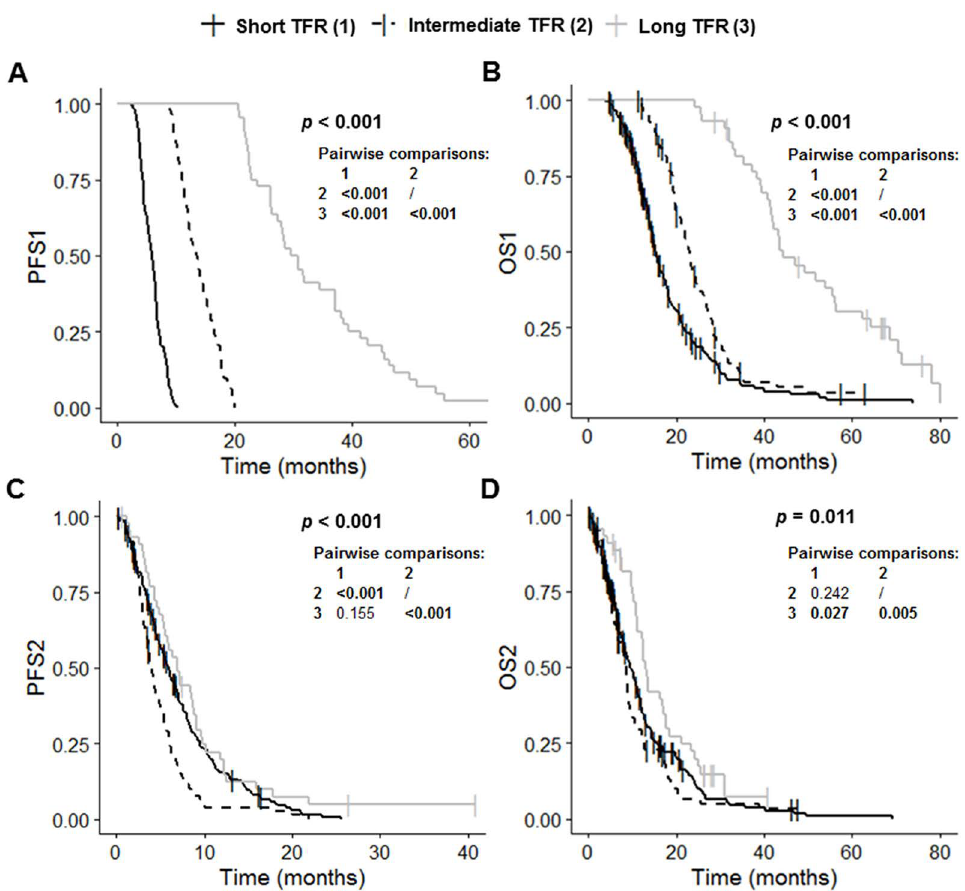
Figure 2. Kaplan–Meier curves for survival stratified for TFR: short TFR ( ≤ 6 months, n = 210), intermediate TFR (7 to 17 months, n = 84) and long TFR ( ≥ 18 months, n = 44). ( A ) PFS1, ( B ) OS1, ( C ) PFS2, and ( D ) OS2. Abbreviations: OS1, overall survival after first surgery; OS2, overall